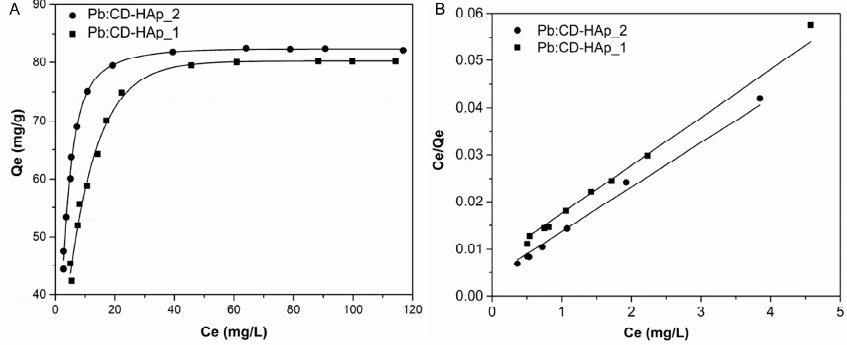
Figure 8. Equilibrium adsorption isotherms for Pb 2+ onto CD-HAp_1 and CD-HAp_2 at room temperature ( A ); and the linearized Langmuir fit ( B ). temperature ( A ); and the linearized Langmuir fit ( B